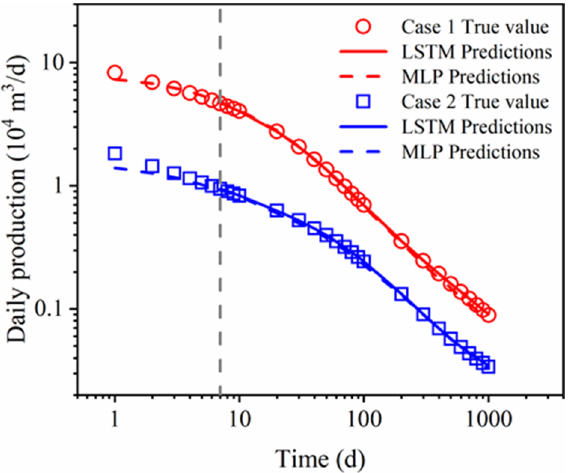
Figure 7. LSTM and MLP predictions and actual values of the daily shale gas production under two constraint conditions.